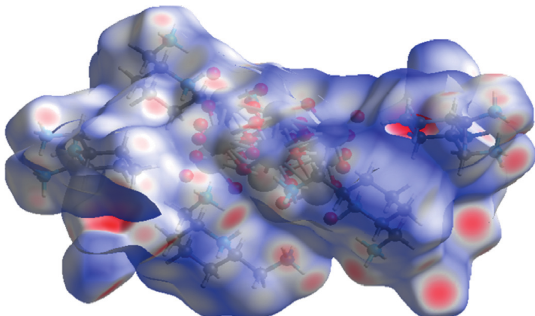
Figure 5: Hirshfeld surface mapped over d